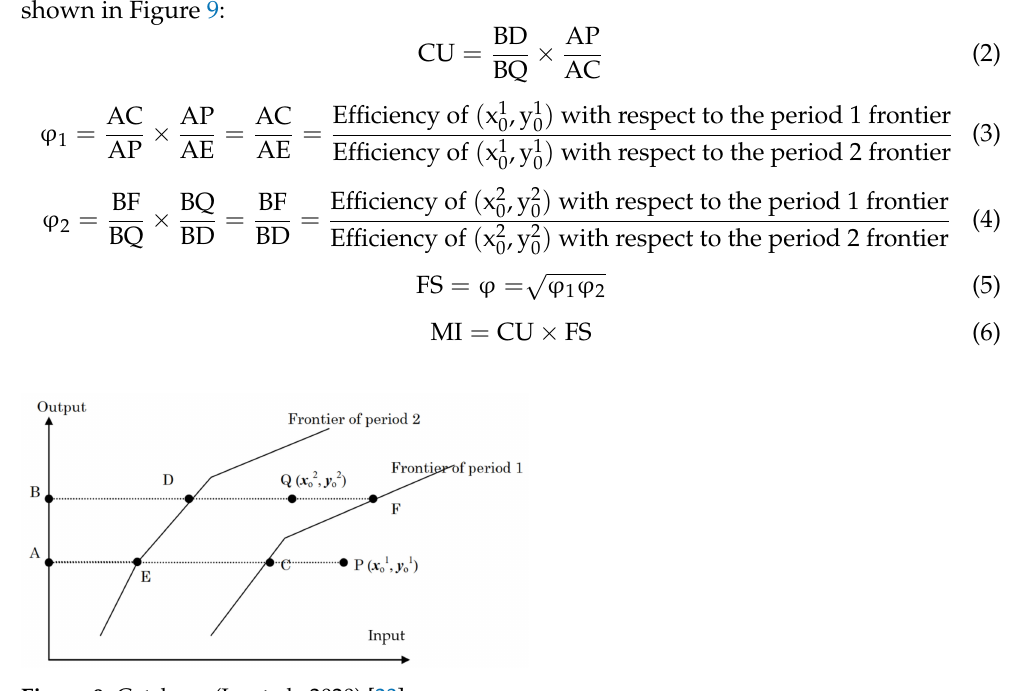
Figure 9. Catch-up (Le et al., 2020)